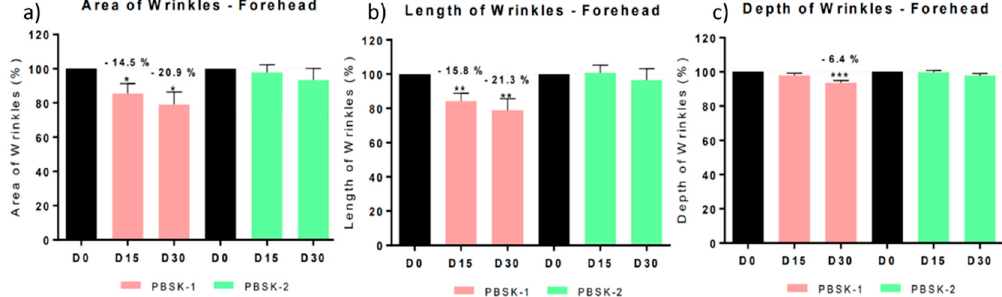
Figure 12. Graphical representation of the total area ( a ), length ( b ) and depth ( c ) of forehead wrinkles before (D 0 ), after 15 days of treatment (D 15 ) and after 30 days of treatment (D 30 ), with mask PBSK-1 or mask PBSK-2, in 30 human volunteers, comparing each volunteer with its own control at D 0 . Statistical significances: * p < 0.05; ** p < 0.01; and *** p < 0.001.